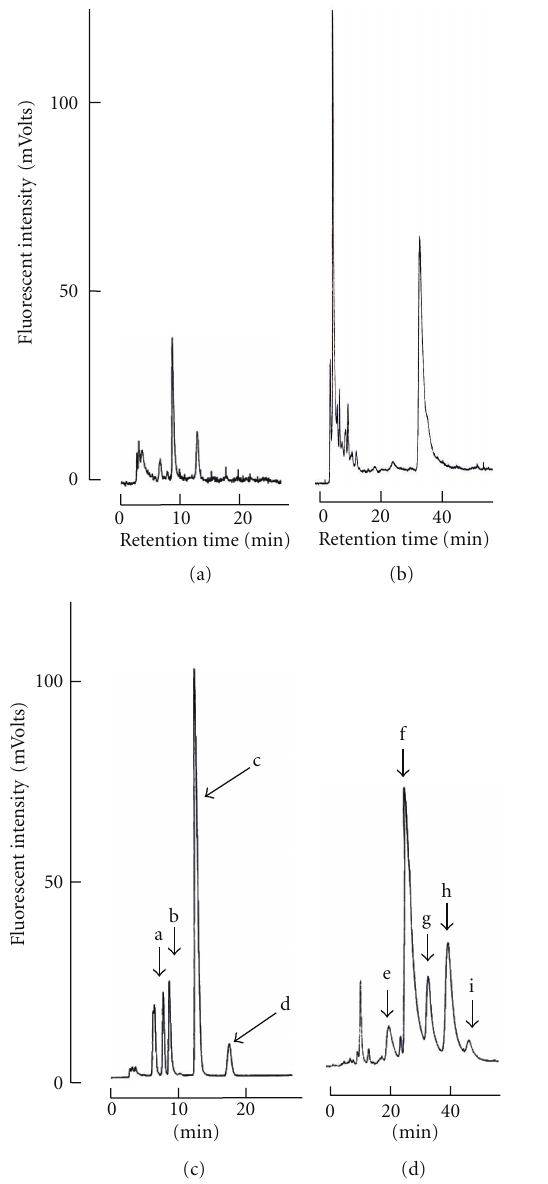
Figure 5: HPLC-FLD analysis for PSP in Demania cultripes . One MU of TTX standard solution was injected to HPLC-FLD system. (a, b) Viscera, (c) GTX stds. ((a: GTX4, b: GTX1, c: GTX3, d: GTX2), (d) STX stds. ((e: hyneoSTX,) f: neoSTX, g: hySTX, h: dcSTX, i: